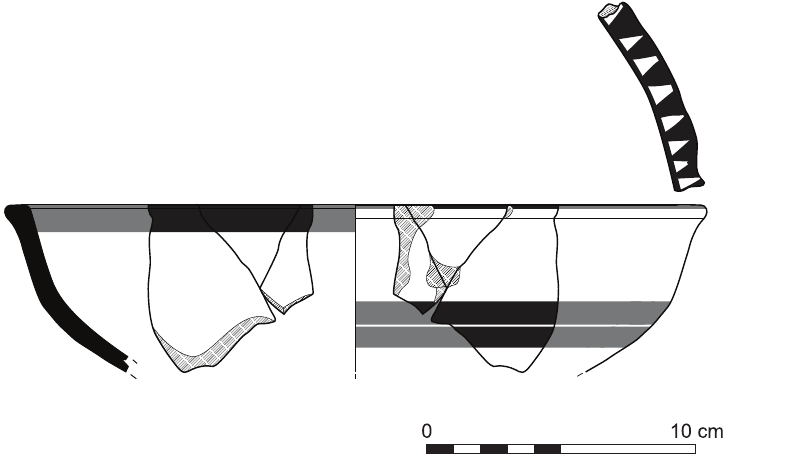
Fig 44. Rim fragment of a shallow bowl, White Painted IV (122409/4483).